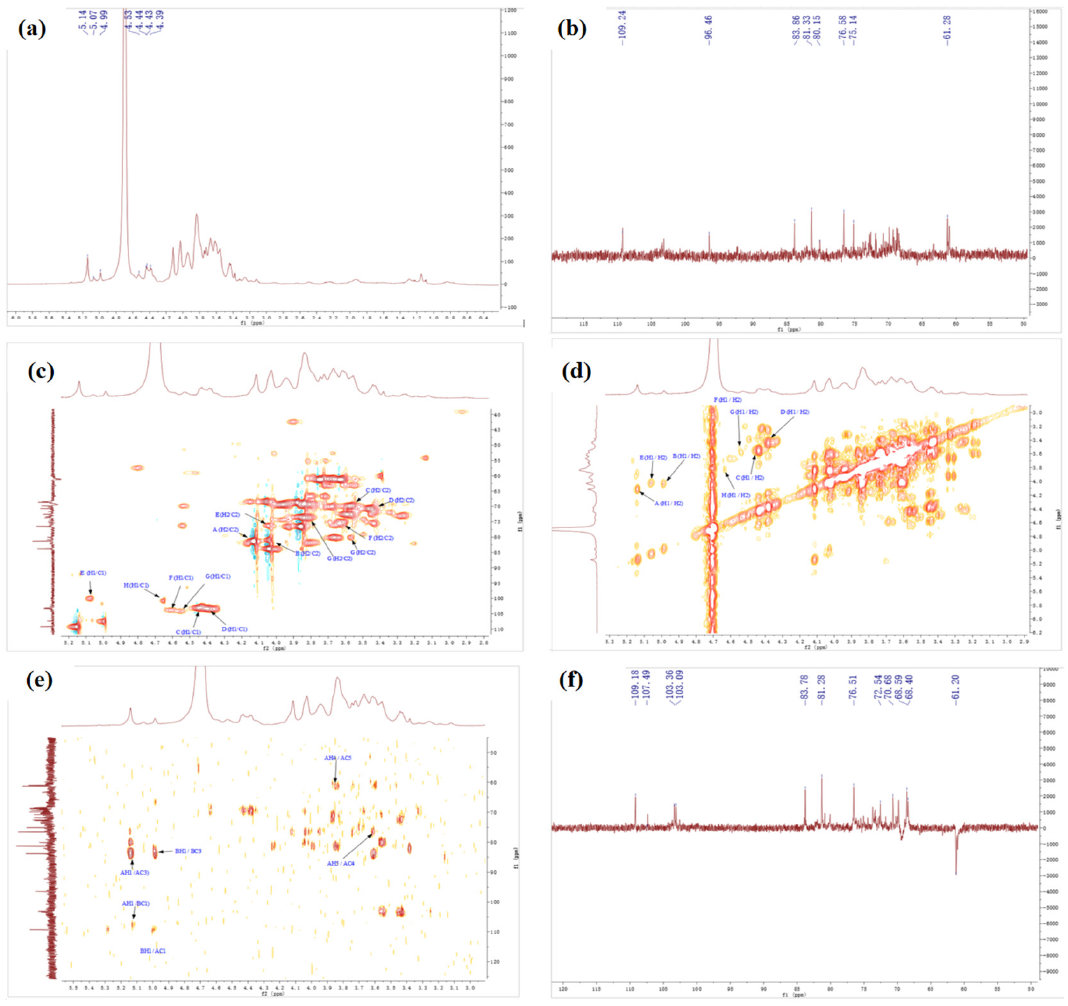
Figure 5. The NMR spectrum of SSP3. ( a ) 1H, ( b ) 13C, ( c ) HSQC, ( d ) COSY, ( e ) HMBC, ( f ) DEPT. Table 6. The 1 H and 13 C chemical shifts of SSP3 backbone.